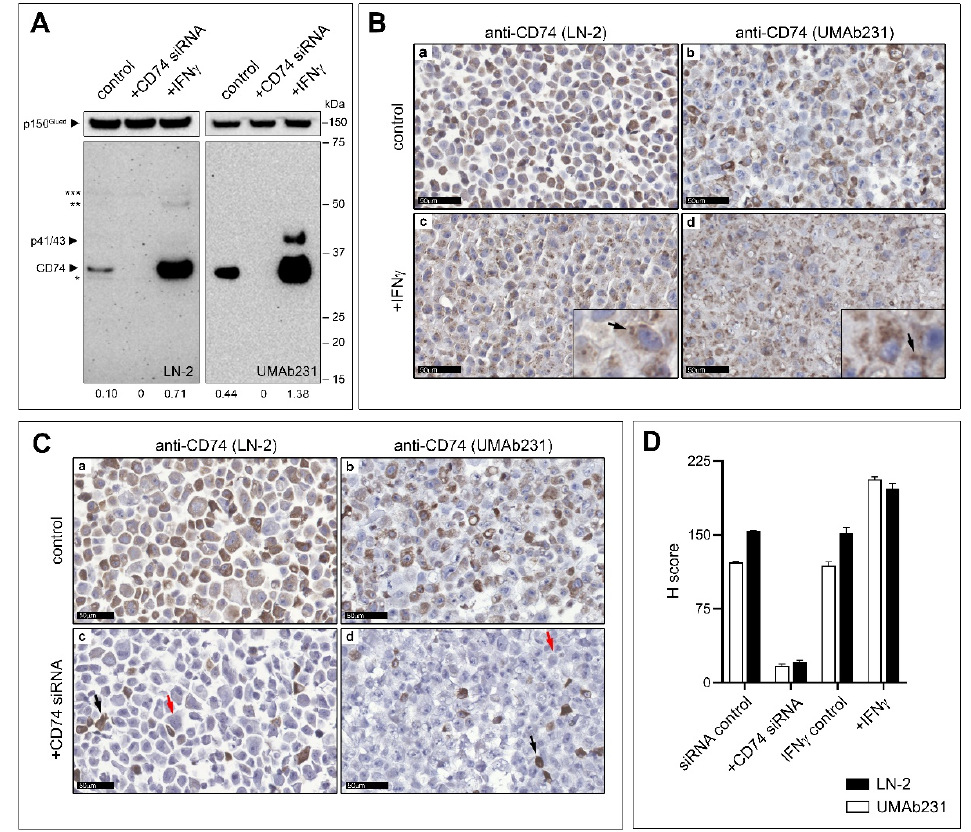
Figure 1. LN-2 and UMAb231 antibody specificity. ( A ) Western blot analysis of CD74 expression was performed by loading whole cell extracts of MDA-MB-231 control cells (control), MDA-MD-231 cells with CD74 siRNA knockdown (+CCD74 siRNA), and IFN γ stimulated MDA-MD-231 cells (+IFN γ ). CD74 protein was detected at 33/35 kDa using either anti-CD74 LN-2 (left-hand panel) or UMAb231 monoclonal antibody (right-hand panel), and at 41/43 kDa with UMAb231 in overexpressing cells. *, **, and *** mark the positions of three independent bands of unknown identity. No signal was detected in siRNA-mediated CD74 knockdown cells (+CD74 siRNA). IHC analysis of FFPE sections of MDA-MB-231 breast cancer control cells compared to ( B ) CD74 siRNA knockdown, and ( C ) IFN γ stimulation showed similar staining patterns with LN-2 and UMAb231 antibodies. Insets in subpanels 1b and 1c show higher magnification images illustrating punctuated stainings of CD74. ( D ) Quantification of stainings showed that IHC immunoreactivity correlated with expression of cellular CD74 protein. Scale bars = 20 µ m. The uncropped blot is shown in Supplementary material Figure